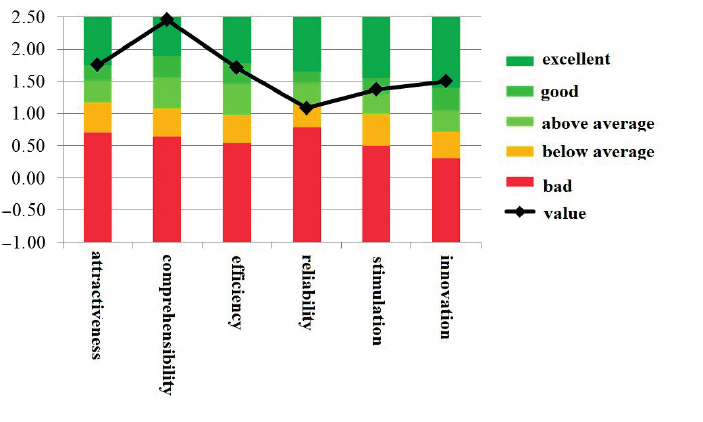
Figure 4. INKHUNTER evaluation results comparison with user experience questionnaire standard (source: created by the